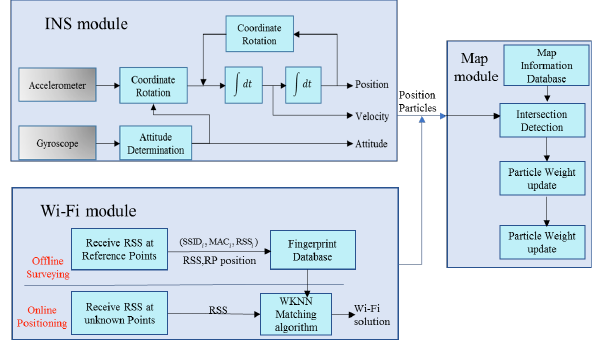
Figure 1. Algorithm structure